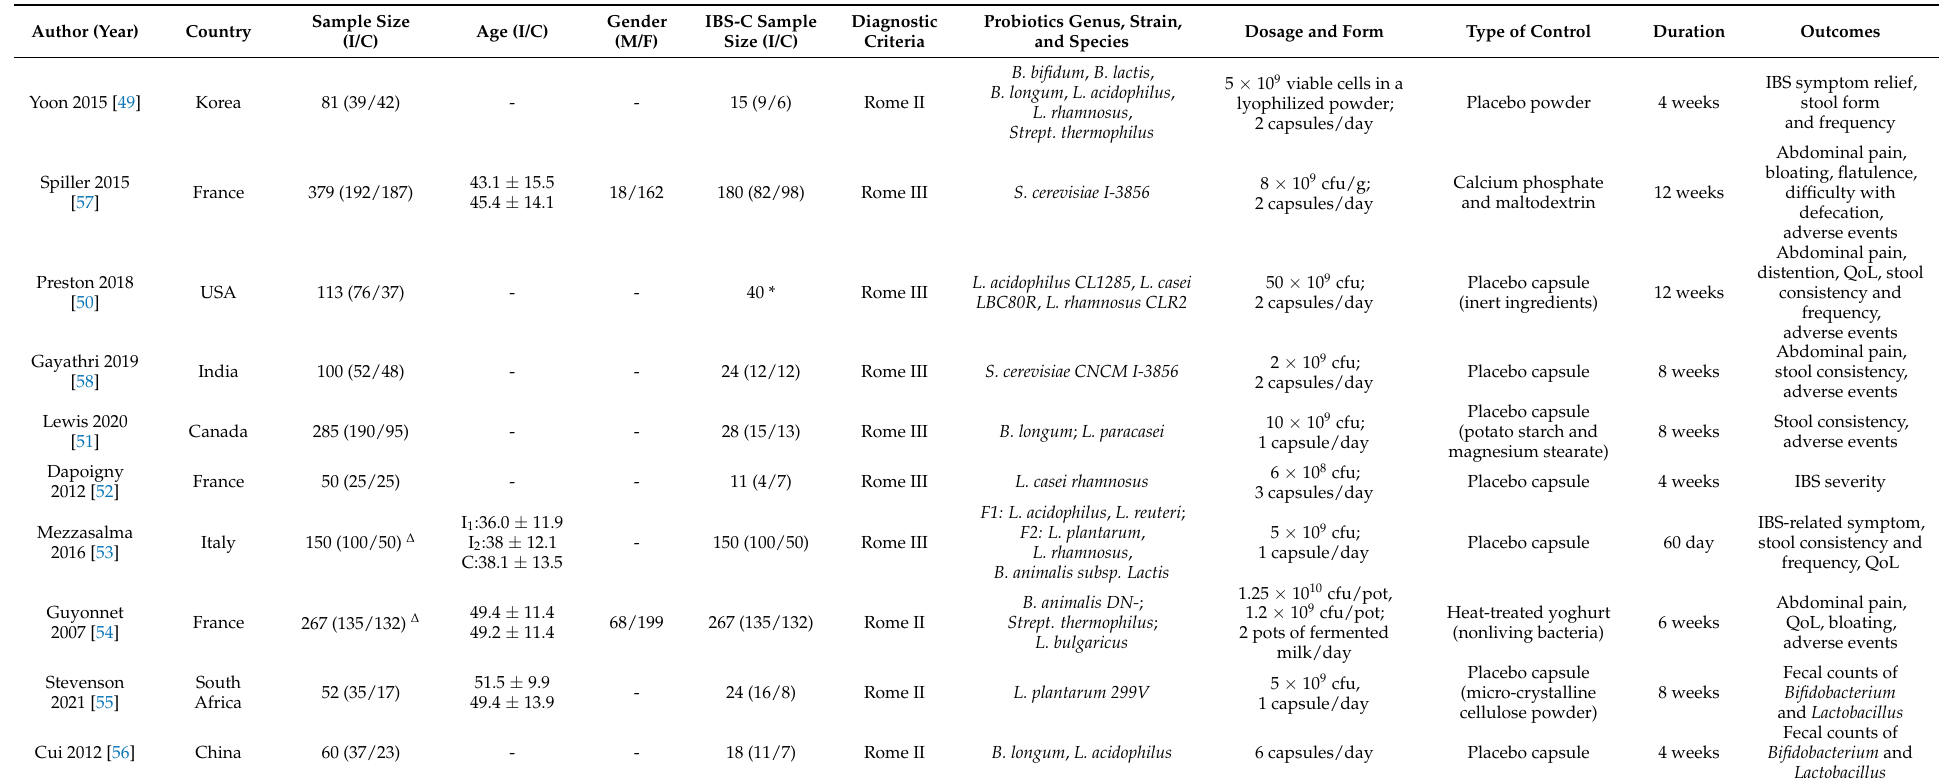
Table 1. The essential characteristics of the included